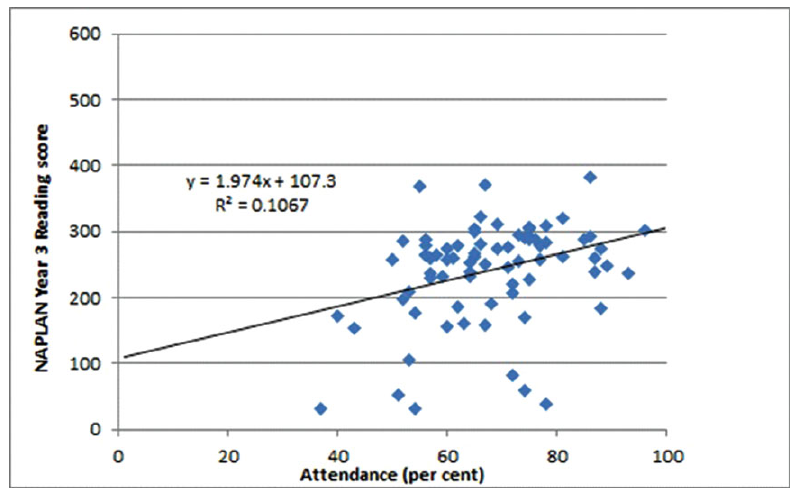
(Colour online) NAPLAN Year 3 Reading scores for very remote schools with greater than 80% Aboriginal and Torres Strait Islander students, by per cent school attendance, 2012 (n = 78).